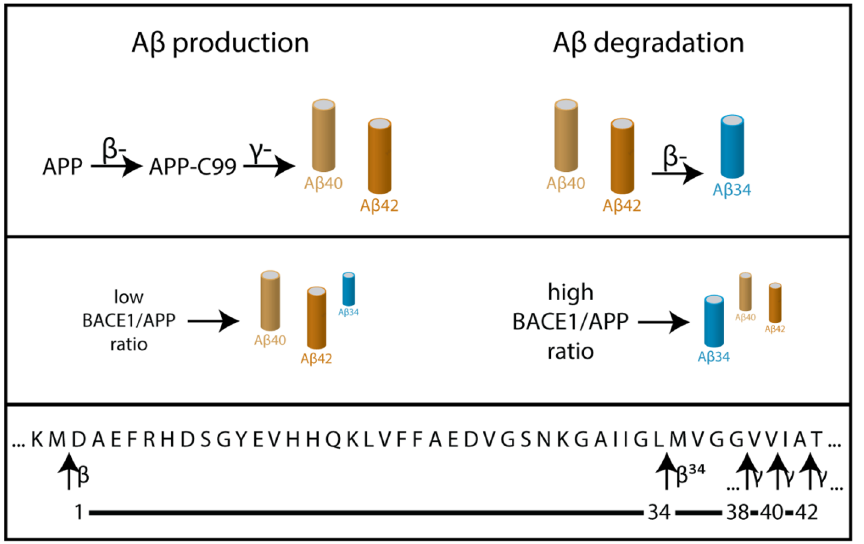
Figure 1. APP processing by β- and γ-secretases and amyloid degradation into Aβ34 at low and high BACE1/ APP ratios. In the amyloidogenic pathway, sequential cleavage of APP by β-secretase and γ-secretase generates Aβ species of varying lengths including Aβ38, Aβ40 and Aβ42. In the Aβ amyloidolytic pathway, Aβ peptides resulting from the production pathway can be cleaved by β-secretase at the β34 site as part of the degradation pathway yielding the C-terminally truncated Aβ species, Aβ34. Under low BACE1/APP ratio, Aβ40 and Aβ42 levels are higher than Aβ34. In contrast, under high BACE1/APP ratio, Aβ34 levels increase as more Aβ40 and Aβ42 are degraded into Aβ34 by